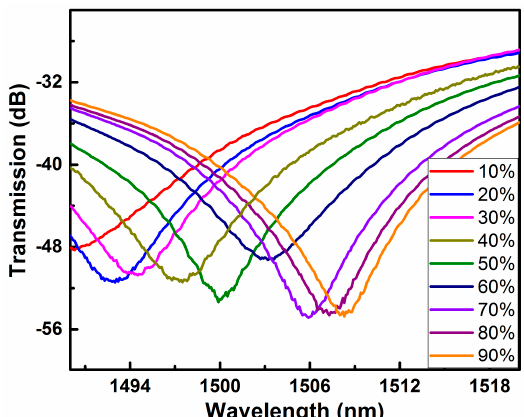
Figure 4. Evolution of transmission spectra of Sample 2 in ethanol aqueous solutions with different concentrations.